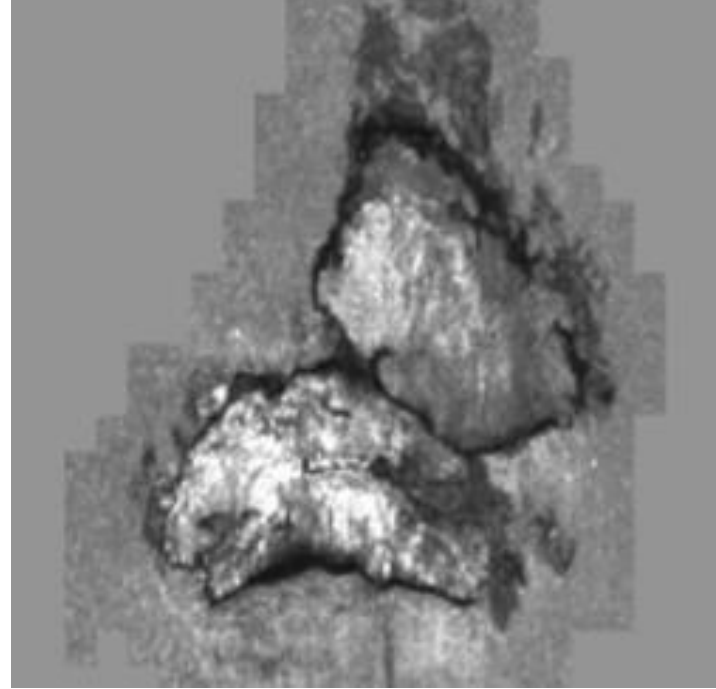
Figure 9. Rolled-in foreign material. Processed in Ametek